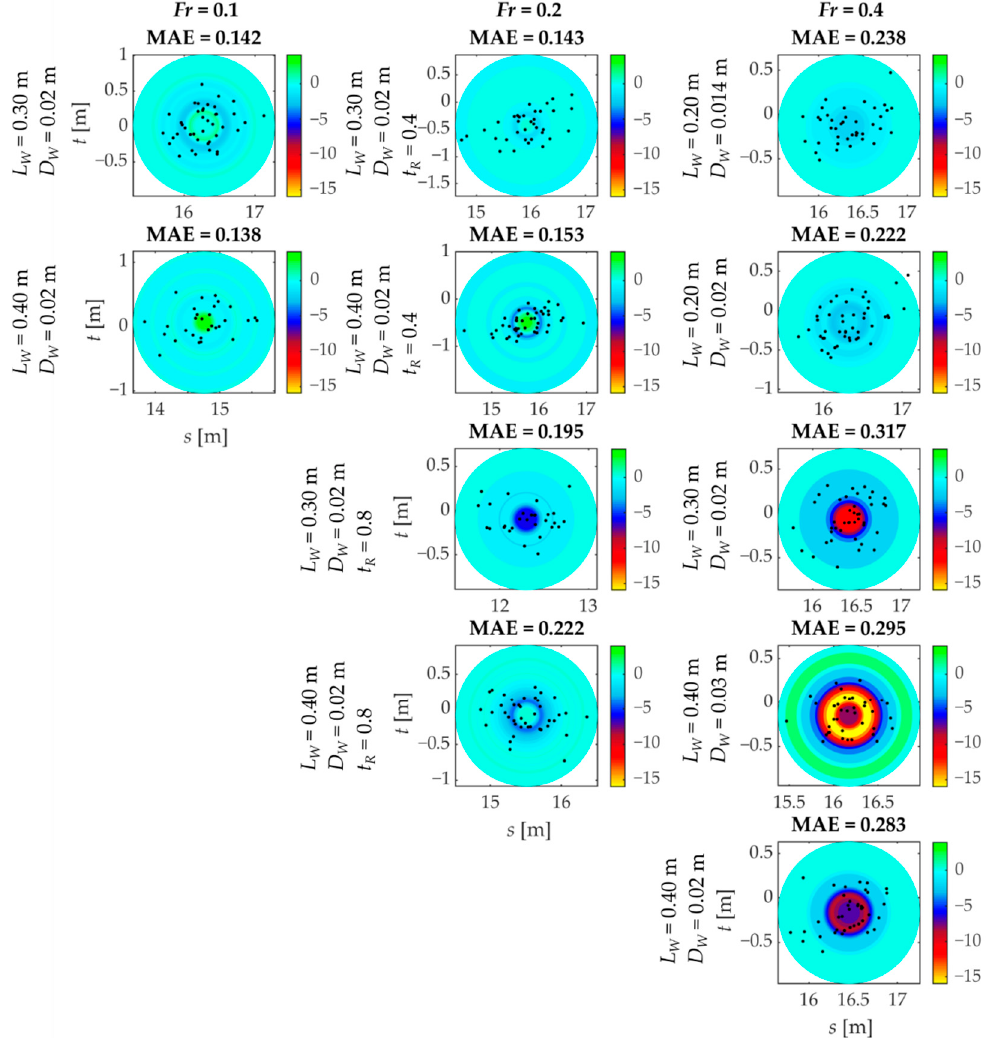
Figure 12. Difference of concentration [kg m − 2 ] for the S-shaped flume. Black dots are the centers of mass of the experimental logs. See Table 1 for the order of the experiments.